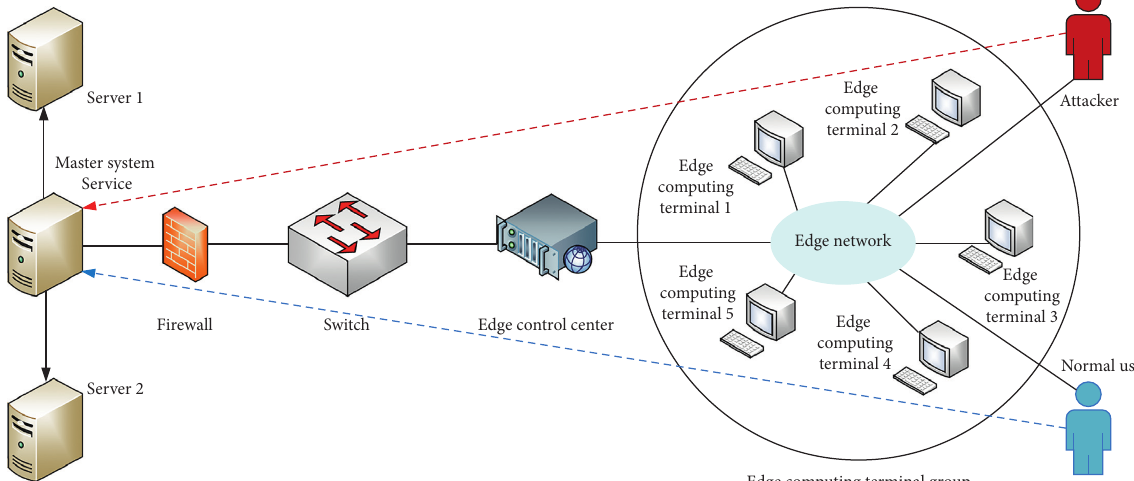
Figure 8: Edge computing network test platform with NS2.